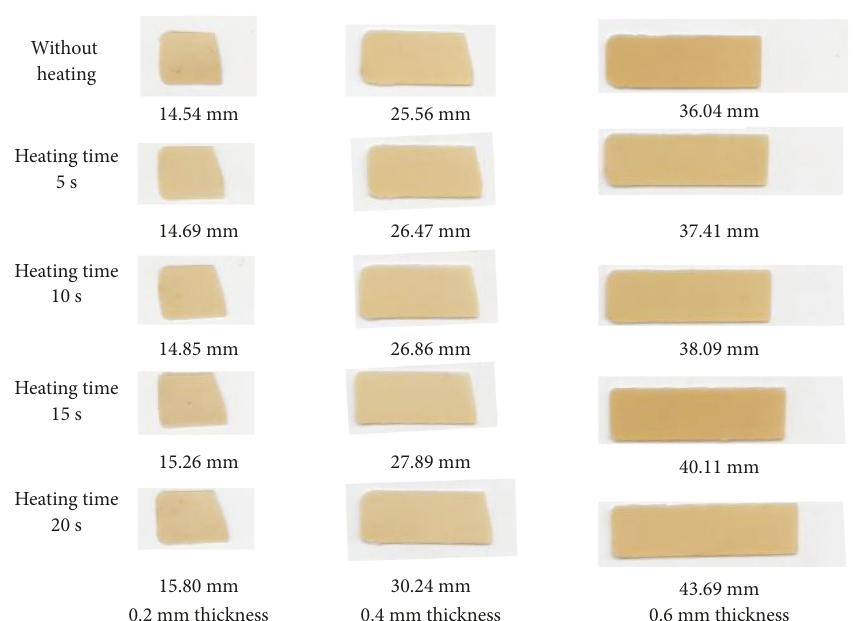
Figure 16: Experimental results for melt flow length with the acrylonitrile butadiene styrene material at different heating times.